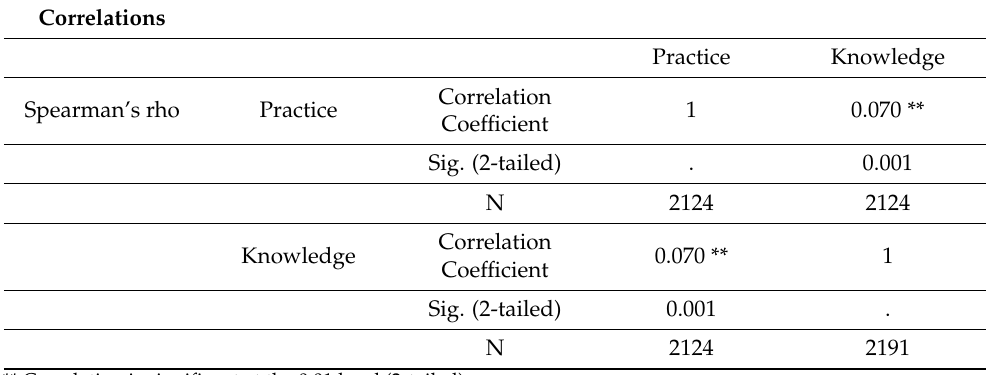
Figure 2. Knowledge and attitude of the target population also showed a negligible positive associ- ation. Table 6. Association of the Spearman correlation between knowledge and attitude. Correlations